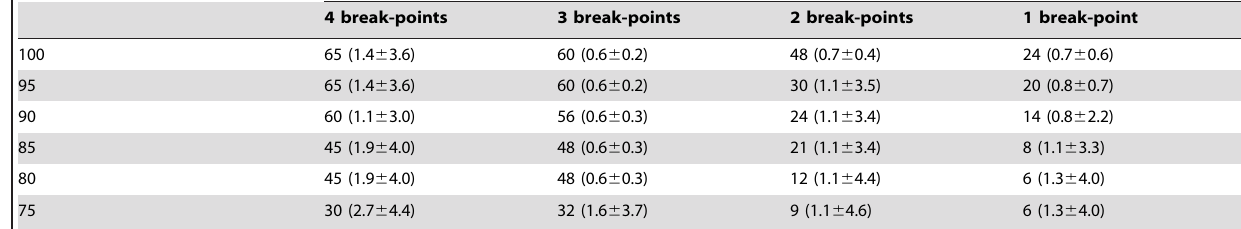
Table 1. Minimum species sample size at which all known break-points in prey preference were detected in 75% to 100% of simulations; and the mean ( 6 SD) absolute difference in prey category between known break-points and detected break-points at each minimum sample